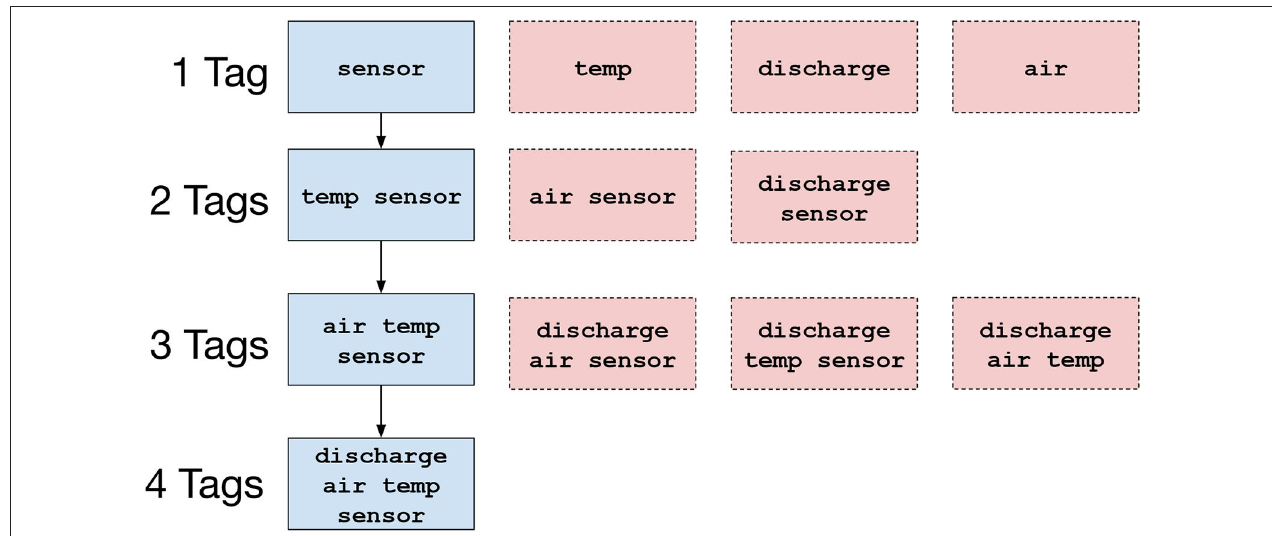
FIGURE 1 | The set of valid (blue + solid outline) and invalid (red + dashed outline) tagsets for a set of four tags. The class hierarchy is established from top to bottom; subclass relationships are indicated by